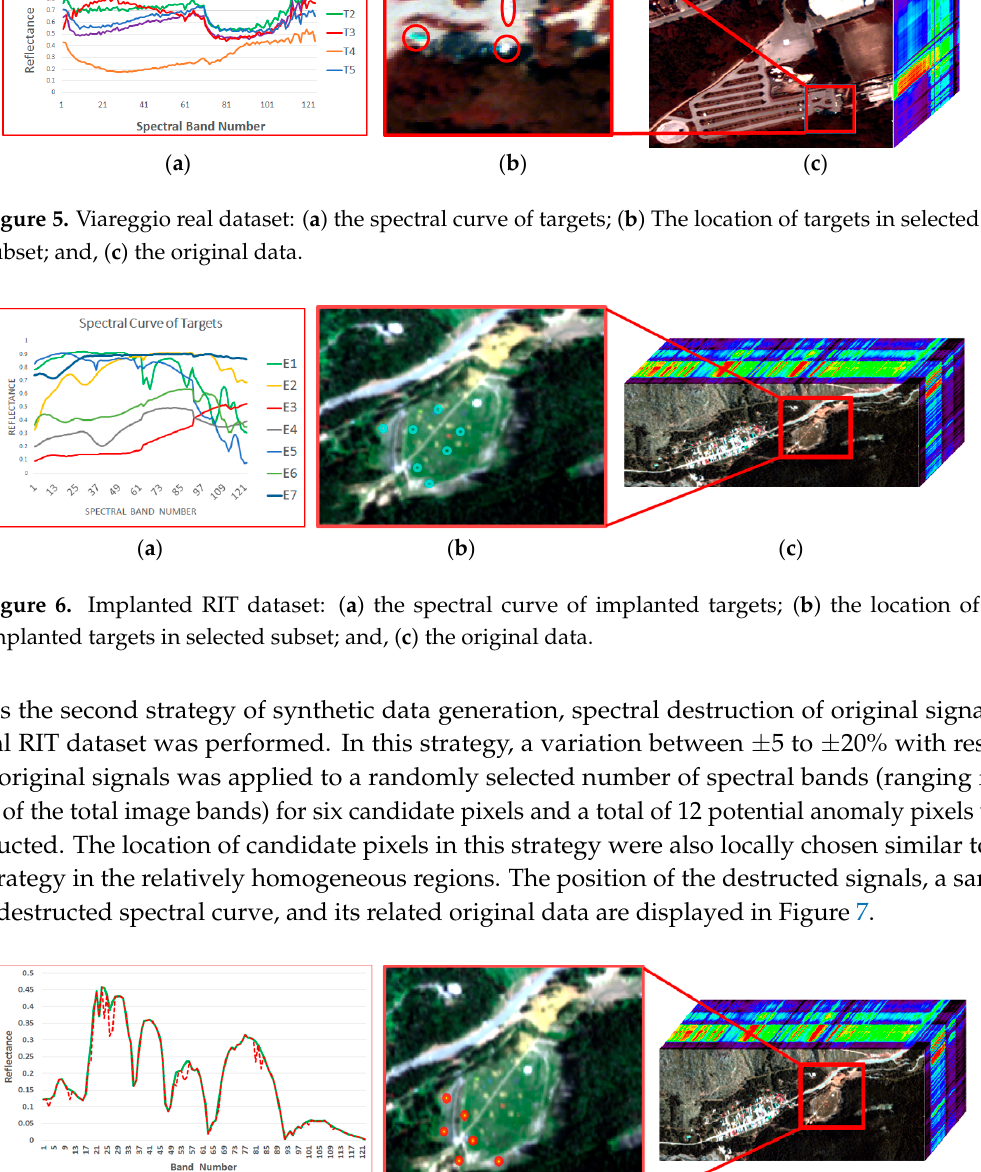
Figure 7. Destructed RIT dataset: ( a ) the spectral curve of destructed targets; ( b ) the location of destructed targets in the selected subset; and, ( c ) the original data.